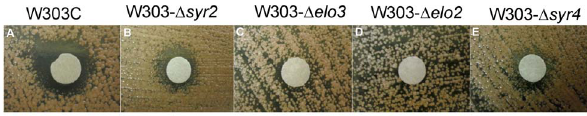
Figure 7. Disk-diffusion antifungal assays of FG08 against S. cerevisiae W303C and sphingolipid biosynthetic mutants. Ten m L aliquots of 1 mg mL 2 1 solutions of FG08 were applied to paper disks placed on YPD medium agar surfaces spread-plated with YPD medium- grown cells of S. cerevisiae strain W303C (A), W303- D syr2 (sur2) (B), W303- D elo3 (C), W303- D elo2 (D) and W303- D syr4 (itp1) (E). The plates were incubated for 48 h at 28 u